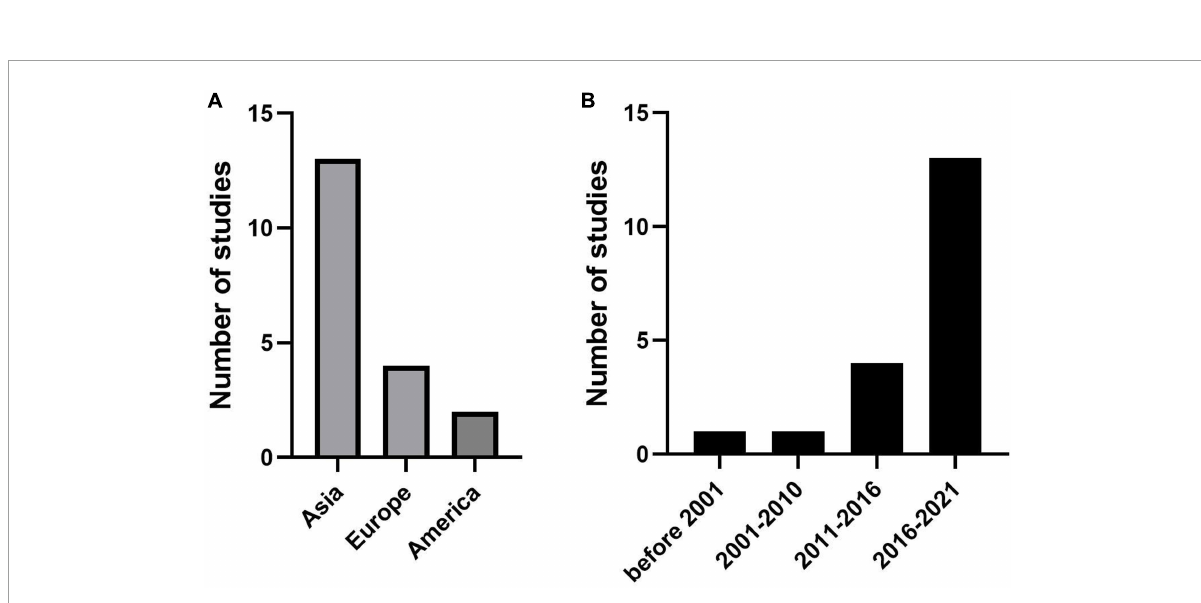
FIGURE2 Publications trends for the coronary artery lesion (CAL) prediction model. (A) The number of studies in different regions. (B) The number of studies in different